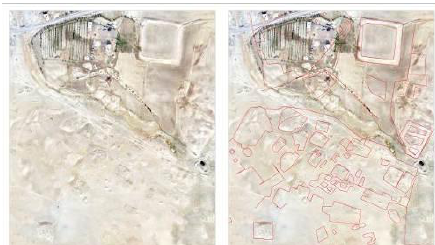
Figure 22 – RPAS orthophoto of the Makhmúr al-Qadima site with overlaid objects of interest on the right picture. - RGB